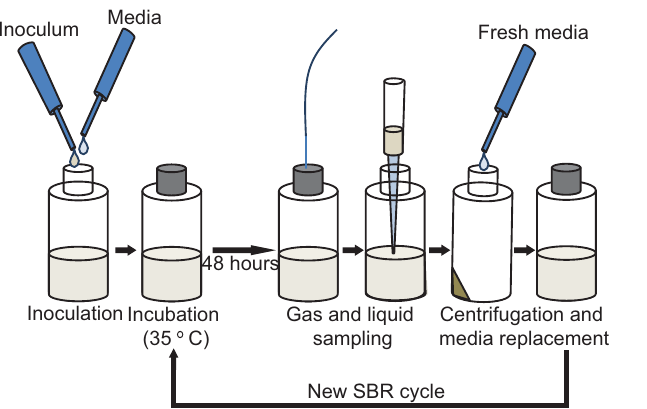
Fig 1. Sequential Batch Reactor (SBR) cycling was performed. SBR cycles involvedcentrifuging microcosms, for 20 minutes at 4,000 g, removalof the supernatant, and additionof fresh media. A total of 7 SBR cycles were performed per